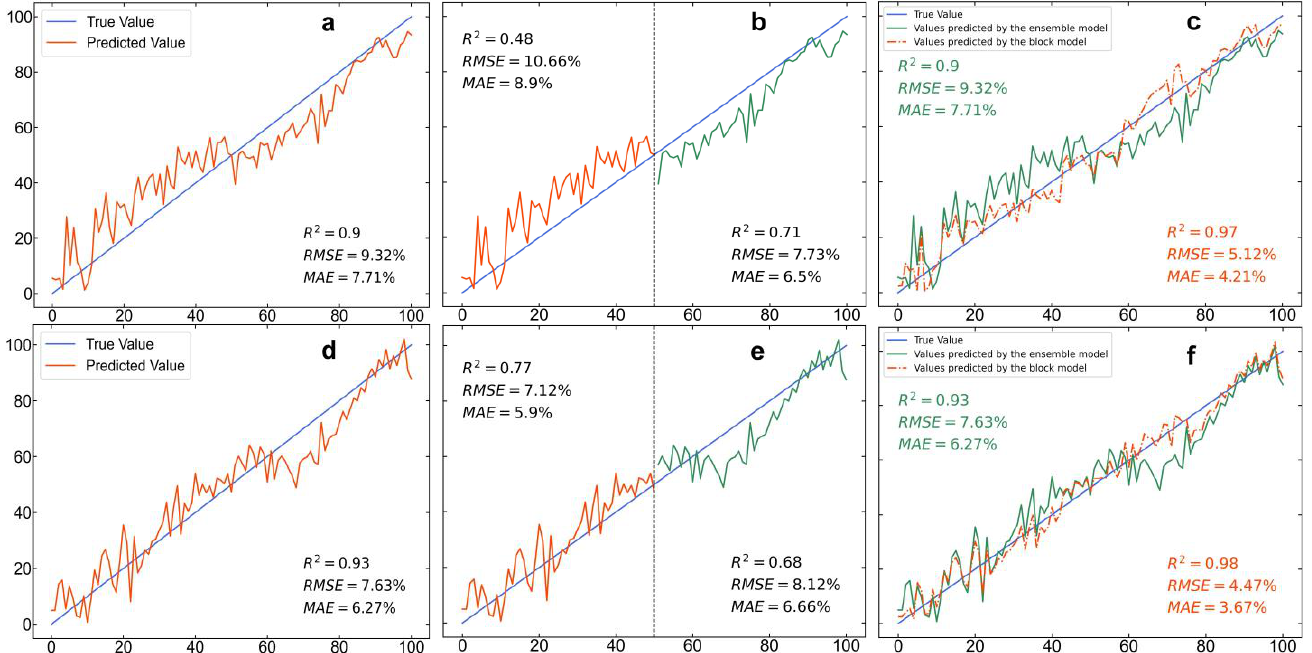
Figure 4. Results of model validation. Panel ( a ) and ( d ) show the predicted result of ensemble model in 2020 and 2021, respectively; panel ( b ) and ( e ) show the predicted effect before and after the demarcation line; panel ( c ) and ( f ) show the predicted result of block model.